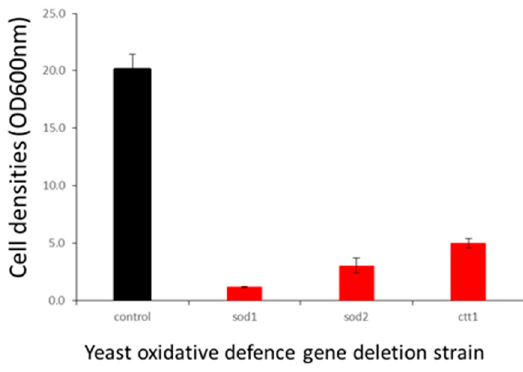
Figure 7. E ff ect of oxidative defense gene deletion on clomipramine sensitivity. Control strains (BY4742) and their derived deletion mutants were grown in YPEth (respiratory medium) in absence (black) or presence of 200 µ M (red) clomipramine with vigorous shaking for good aeration. Cell densities (OD600 nm) were estimated after three days of growth.